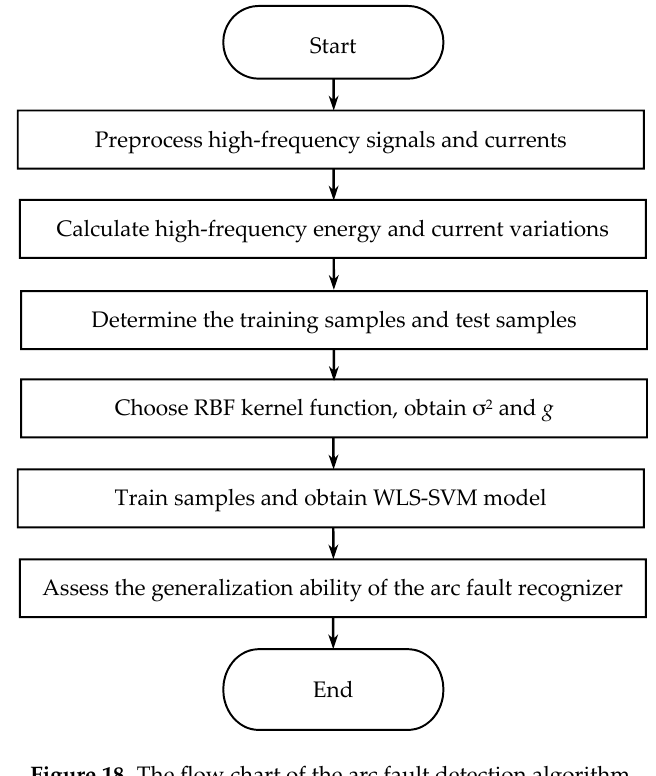
Figure 18. The flow chart of the arc fault detection algorithm.